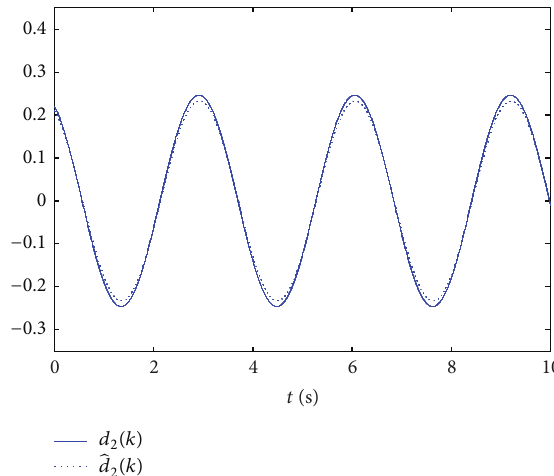
Figure 12: The disturbance 𝑑 1 (𝑘) and theestimation output of